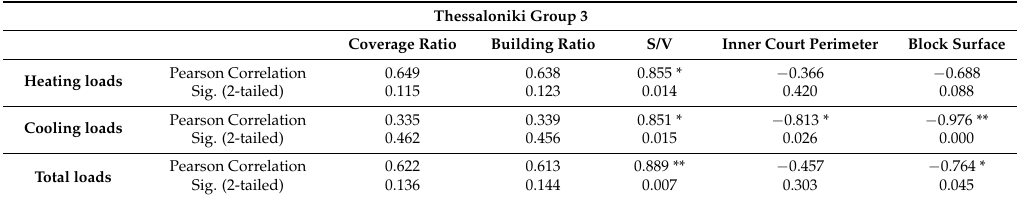
Table 12. Correlation of form parameters to load demand of the urban blocks of group 3 for the climate of Thessaloniki.